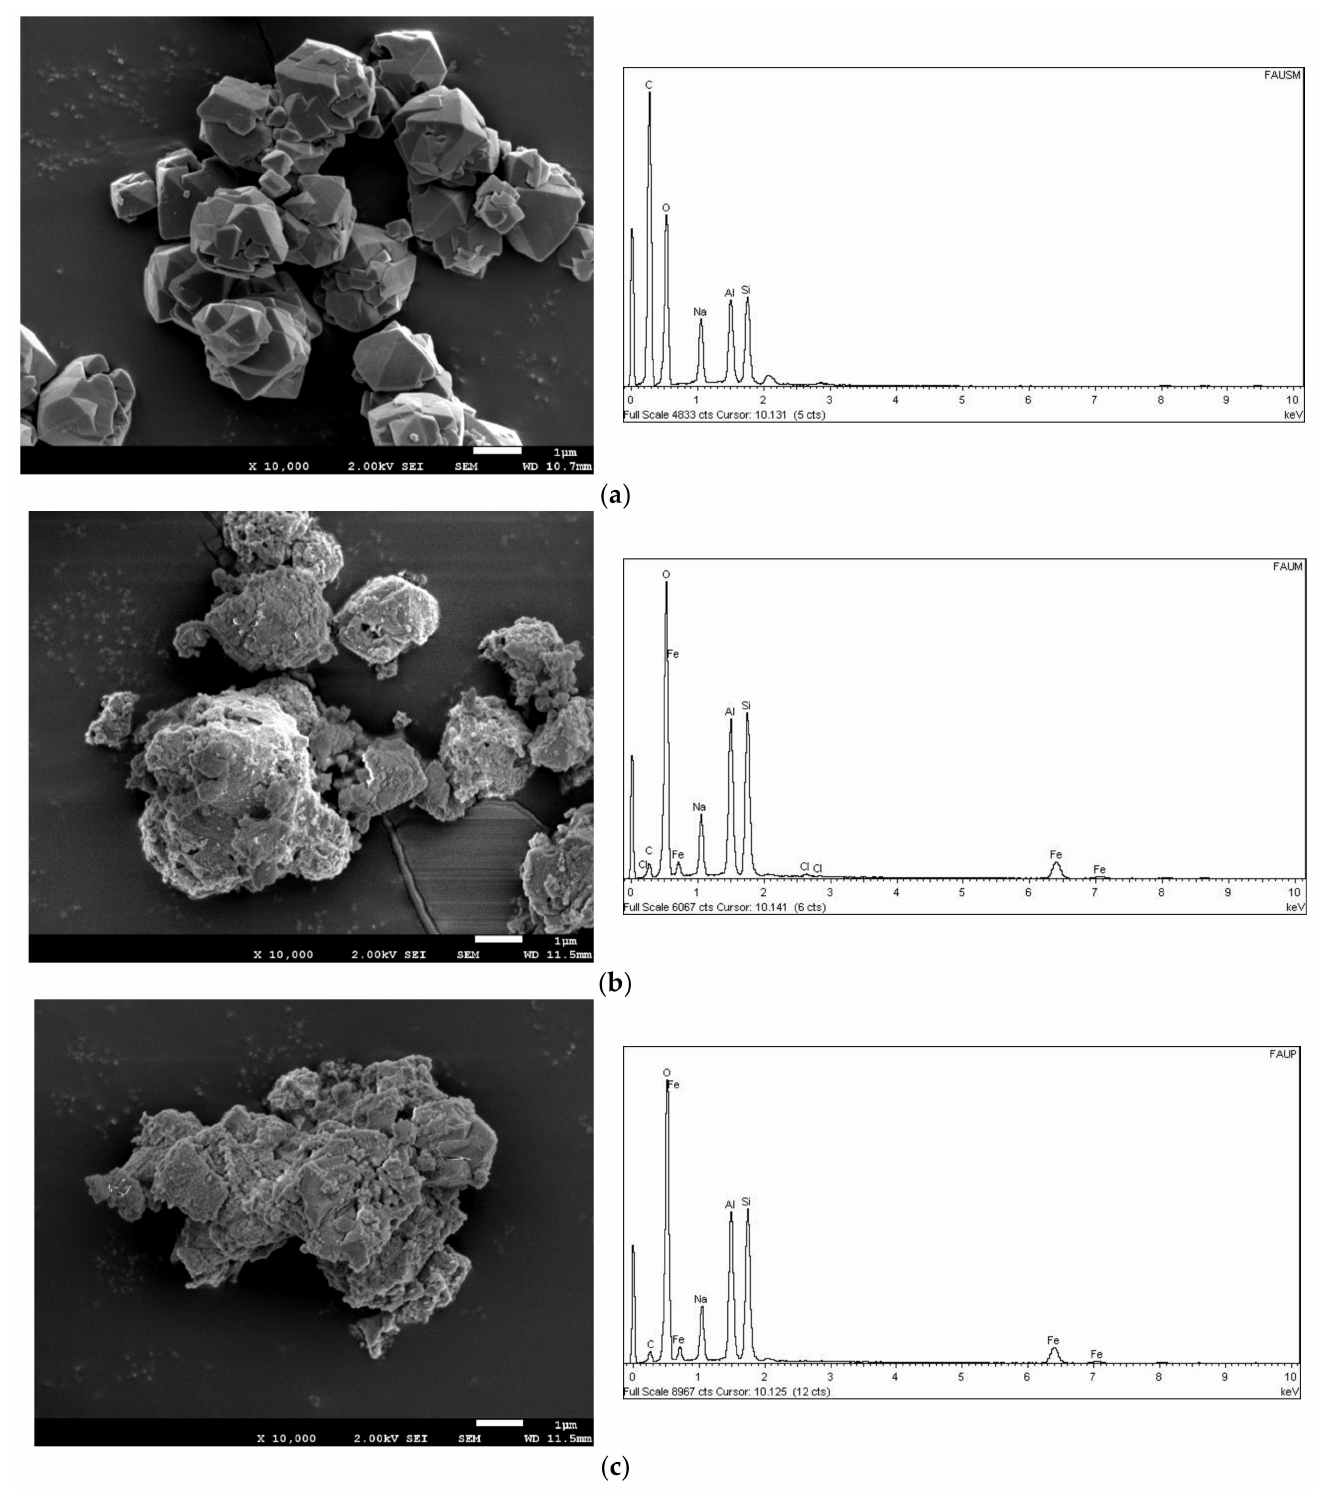
Figure 2. FSEM-EDX of the faujasite X zeolite: ( a ) parent form FAU-X, ( b ) iron form FAU-X-Fe, and ( c ) loaded